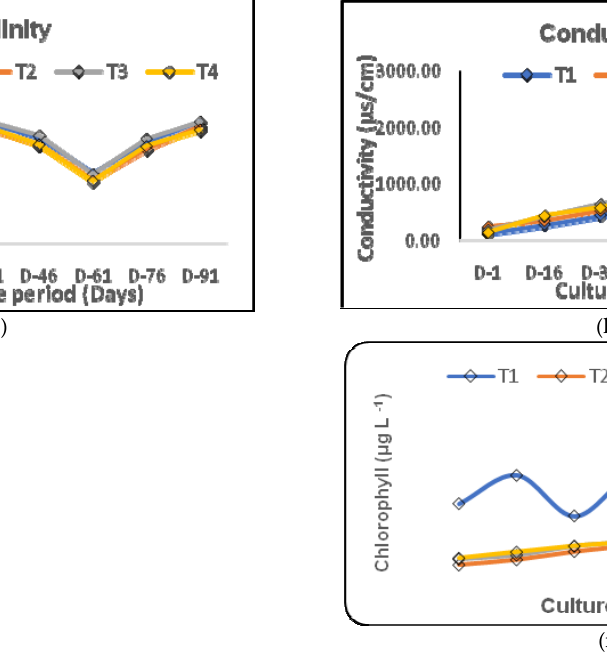
Figure 1. Variations in different water quality parameters:( a ) temperature,( b ) DO,( c ) pH,( d ) TDS,( e ) TSS,( f ) floc volume,( g ) TAN,( h ) nitrite ‐ N,( i ) nitrate ‐ N,( j ) alkalinity,( k ) conductivity,( l ) BGA and ( m ) chlorophyll in the experimental biofloc units for the seed rearing of O. bimaculatus at different stocking densities.